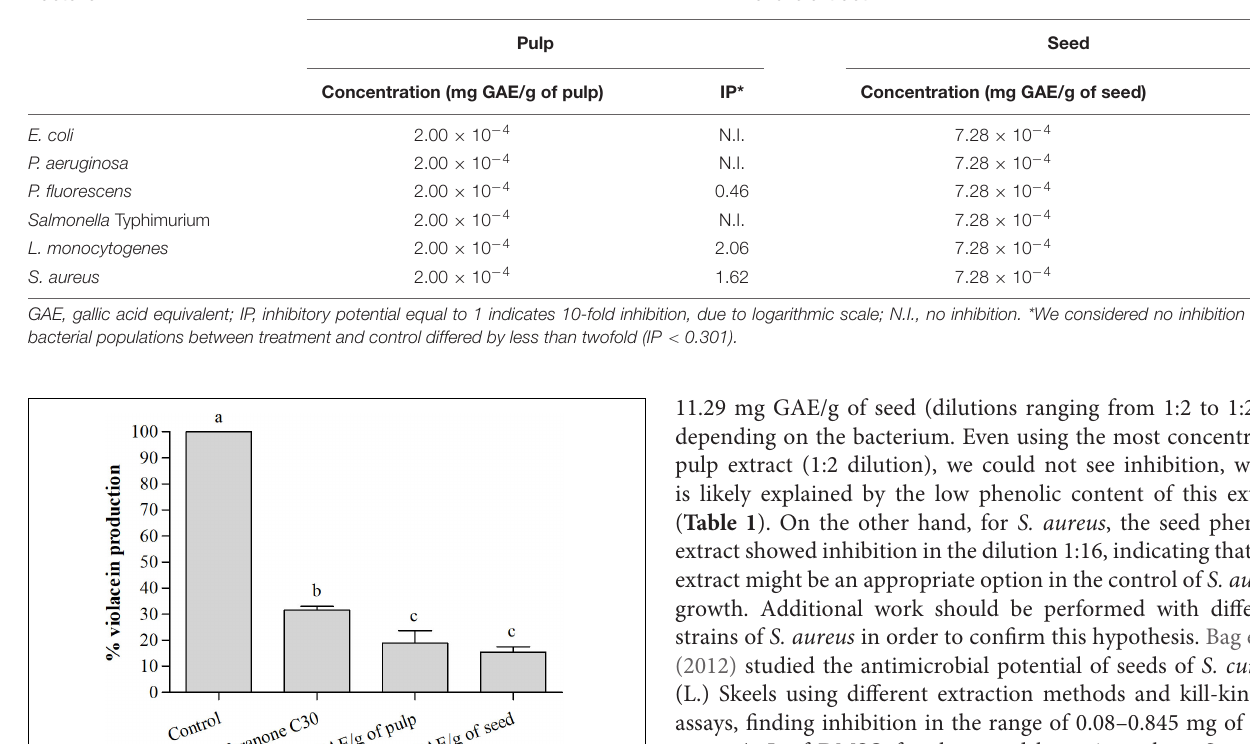
TABLE 4 | Inhibitory Potential (IP) of the active films incorporating pulp and seed phenolic extracts of S. cumini (L.) Skeels against the evaluated bacteria. Bacteria Phenolic extract